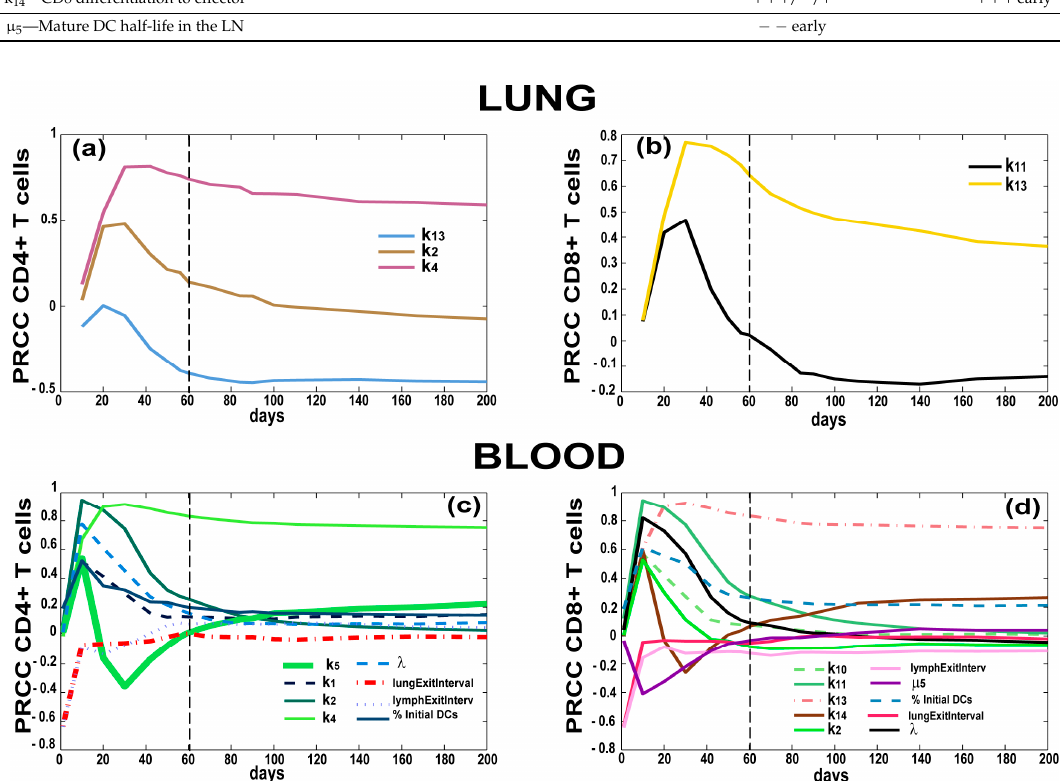
Figure 7. Partial Ranked Correlation Coefficient (PRCC) time courses of mechanisms/parameters affecting adaptive immune response in the lung and blood compartments. Each plot has days post infection (up to 200 days) on the x -axis and PRCC values on the y -axis (between − 1 and 1). The PRCCs plotted are the only ones that resulted significant (i.e., p < 10 − 3 ) and with an absolute value greater than 0.3. Outcomes shown are Mtb-specific Effector T cells in the lung (( a ) CD4+ T cells and ( b ) CD8+ T cells) and in the blood (( c ) CD4+ T cells and ( d ) CD8+ T cells). Parameter definitions: k 2 —Naïve CD4+ T cell priming, k 4 —CD4+ T cell precursor proliferation, k 13 —CD8+ T cell precursor proliferation, k 14 —CD8+ T cell differentiation to effector, k 11 —Naïve CD8+ T cell priming, λ :